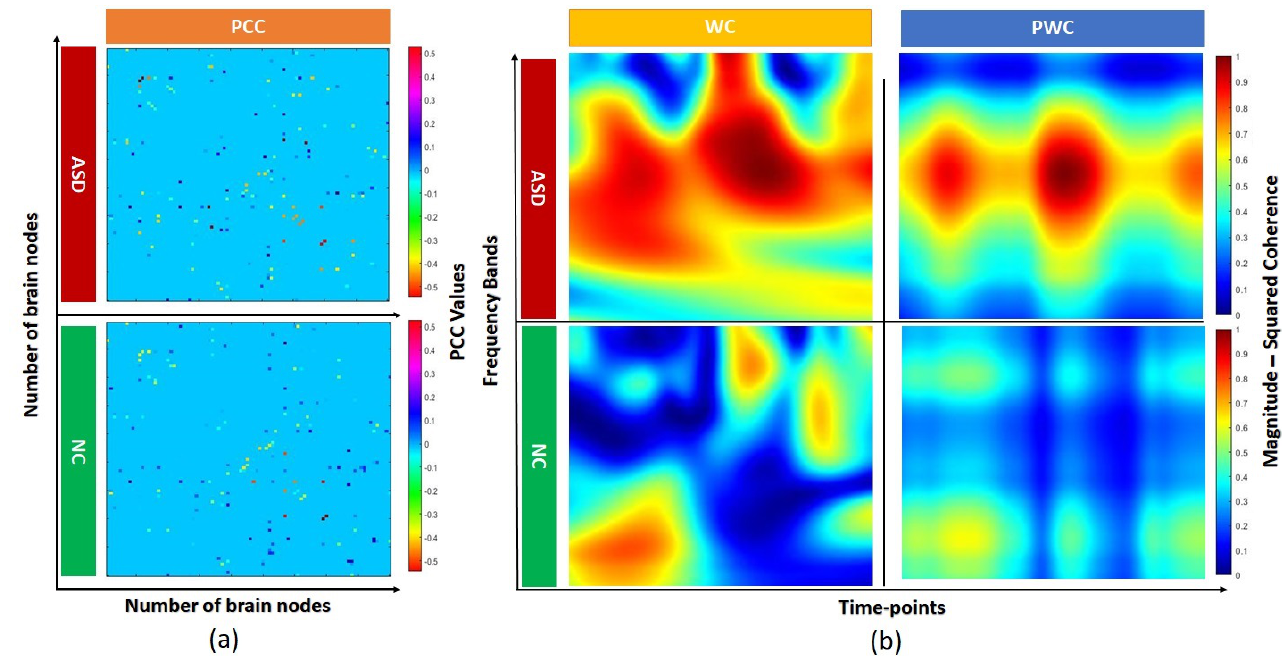
Figure A1. Samples of FC images for ASD and NC: ( a ) PCC, which is a type of SFC; and ( b ) WC and PWC, which is a type of